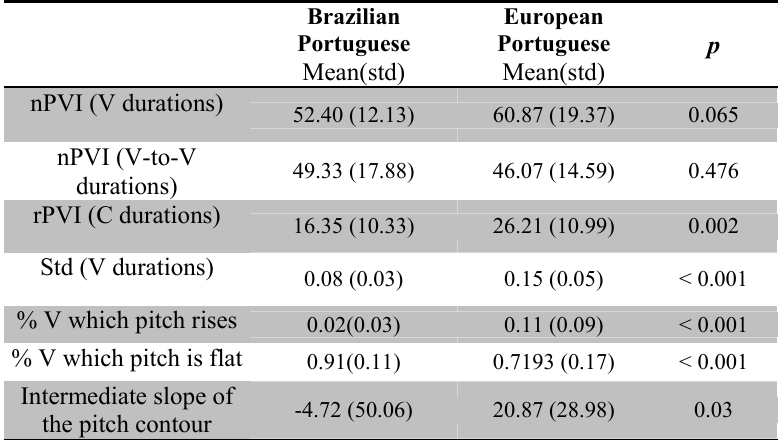
Table VI: Mean, standard deviation and p-value for a group of features, considering Brazilian and European Portuguese singing